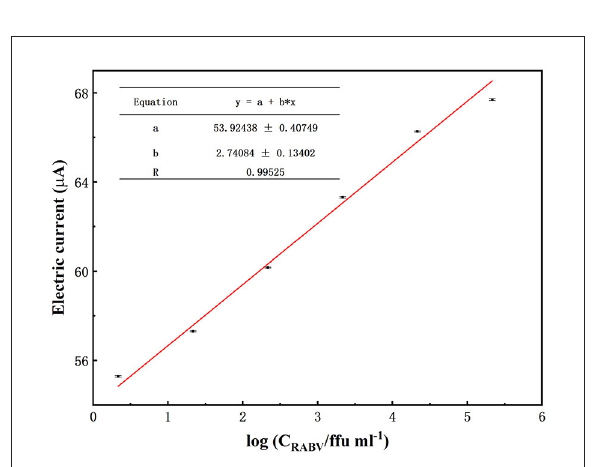
FIGURE4 Biosensor response to different concentrations of